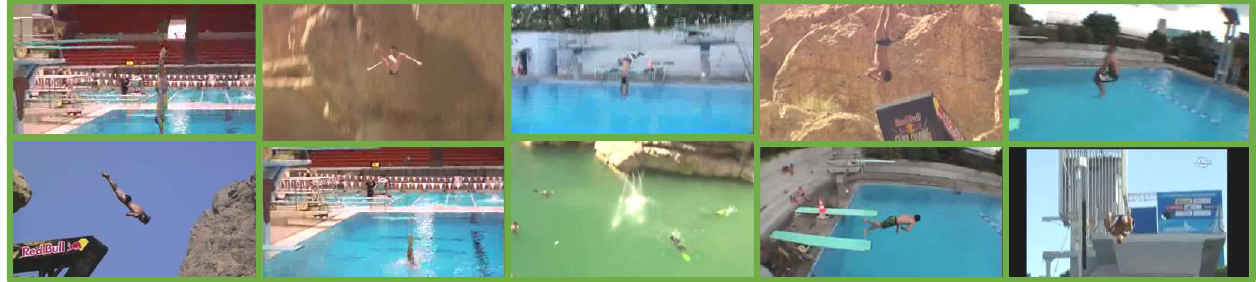
Figure 5. Results of our mining of representative video parts with our method on the MED11 Dataset. The illustrations are of representative parts of diving videos. Our approach can capture the video clips that contain semantics such as “air manoeuvre” and “take into water”, which are the kernel modes of diving